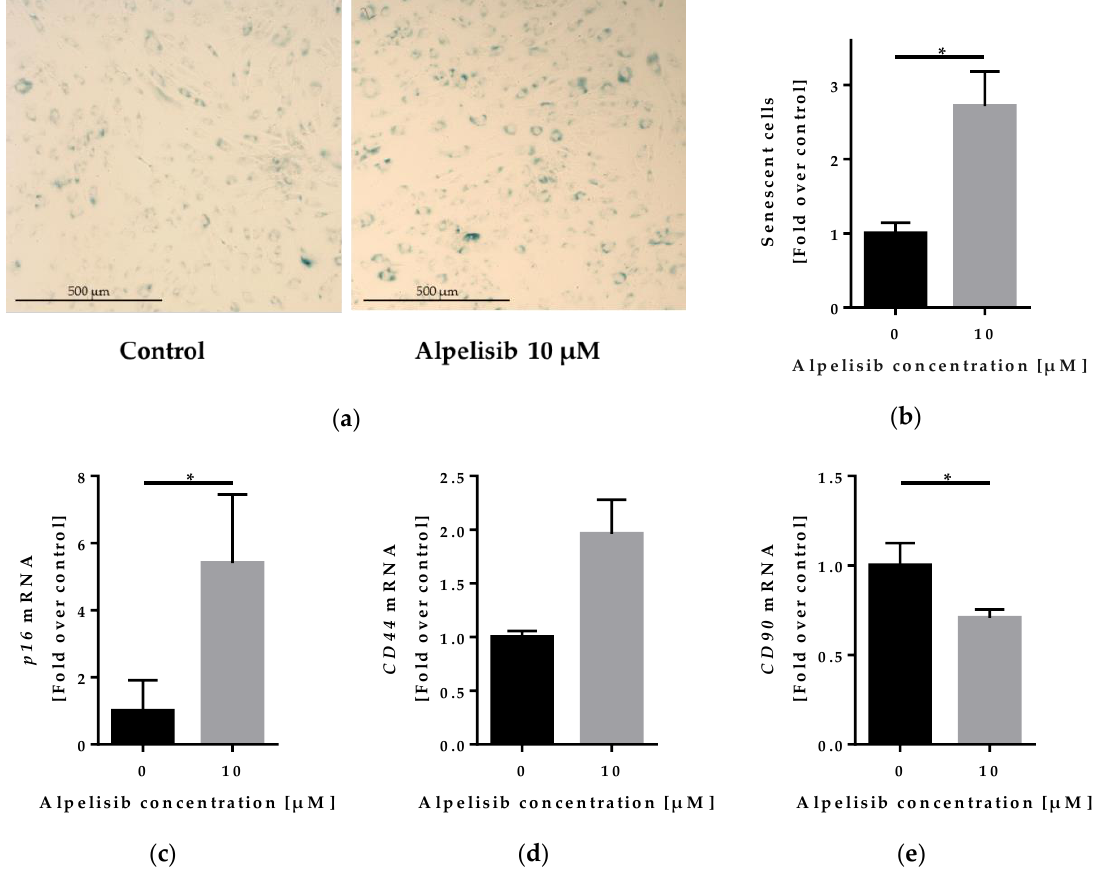
Figure 7. β -galactosidase senescence staining of LipPD1 cells after 72 h alpelisib treatment: ( a ) β -galactosidase staining showed a higher number of senescent (blue) cells after 10 µM alpelisib treatment; ( b ) the fraction of senescent cells increased with 10 µM alpelisib compared to solvent control, n = 3, * p = 0.027. RT-qPCR of senescence and stem cell marker genes from LipPD1 cells after 10 days of differentiation with or without 10 µM alpelisib: mRNA expression of ( c ) p16 was upregulated, ( d ) CD44 was upregulated ( p = 0.053), and ( e ) CD90 was downregulated in 10 µM alpelisib-treated cells. Fold over control, values were normalized to the housekeeper gene β -actin , n = 3, * p ≤ 0.05. The fraction of senescent cells after 72 h alpelisib treatment was elevated 2.71 ± 0.47 fold, indicating cell cycle arrest. Similar observations were made for LipPD2 (2.43 ± 0.7 fold, p = 0.236) and LipPD3